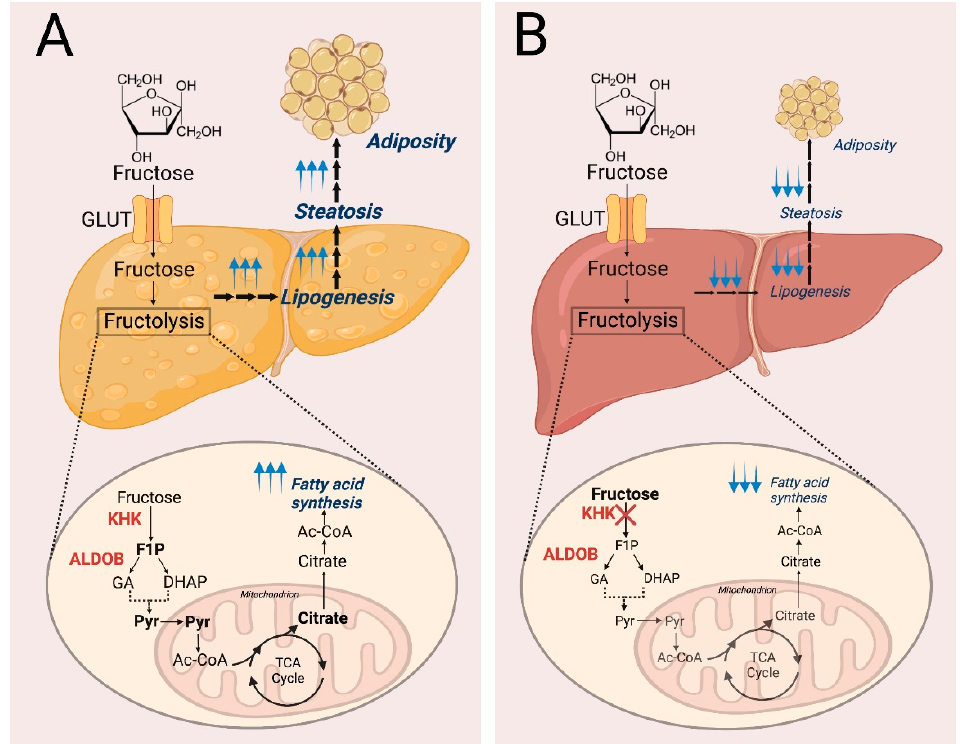
Figure 2 . The protective role of KHK deletion against the development of sugar-induced metabolic syndrome. ( A ) Hepatocytes with functional KHK can metabolize fructose through fructolysis and this can contribute to liver steatosis and adiposity. ( B ) KHK deficiency in hepatocytes inhibits fructolysis and serves a protective role against liver steatosis and adiposity. Enzymes are shown in bold red, metabolites are black, pathway outcomes are italicized navy. Upwards and downwards blue arrows are indicative of activity being upregulated or downregulated, respectively. Proteins: GLUT, Glucose transporter; KHK, Ketohexokinase; ALDOB, Aldolase B; Metabolites: F1P, Fructose-1-phosphate; GA, Glyceraldehyde; DHAP, Dihydroxyacetone phosphate; Pyr, Pyruvate; Ac-CoA, Acetyl-CoA; Citrate; Pathway: TCA cycle, Tricarboxylic acid cycle.